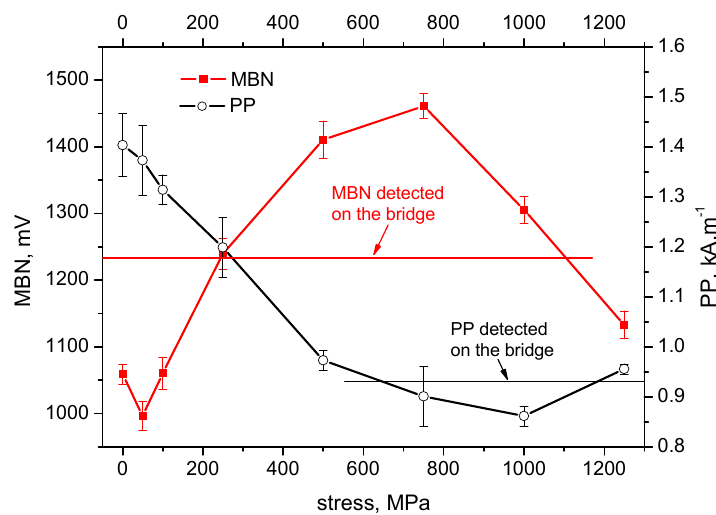
Figure 4. MBN and PP as a function of stress—wire n.1. Materials 2020 , 1 FOR PEER REVIEW